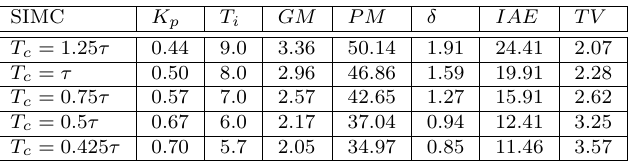
Table 4: PI-controller settings for an integrating plus